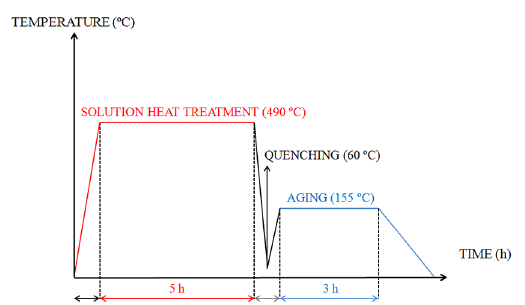
Figure 2. Schematic representation of the stages of the T6-heat treatment applied in this